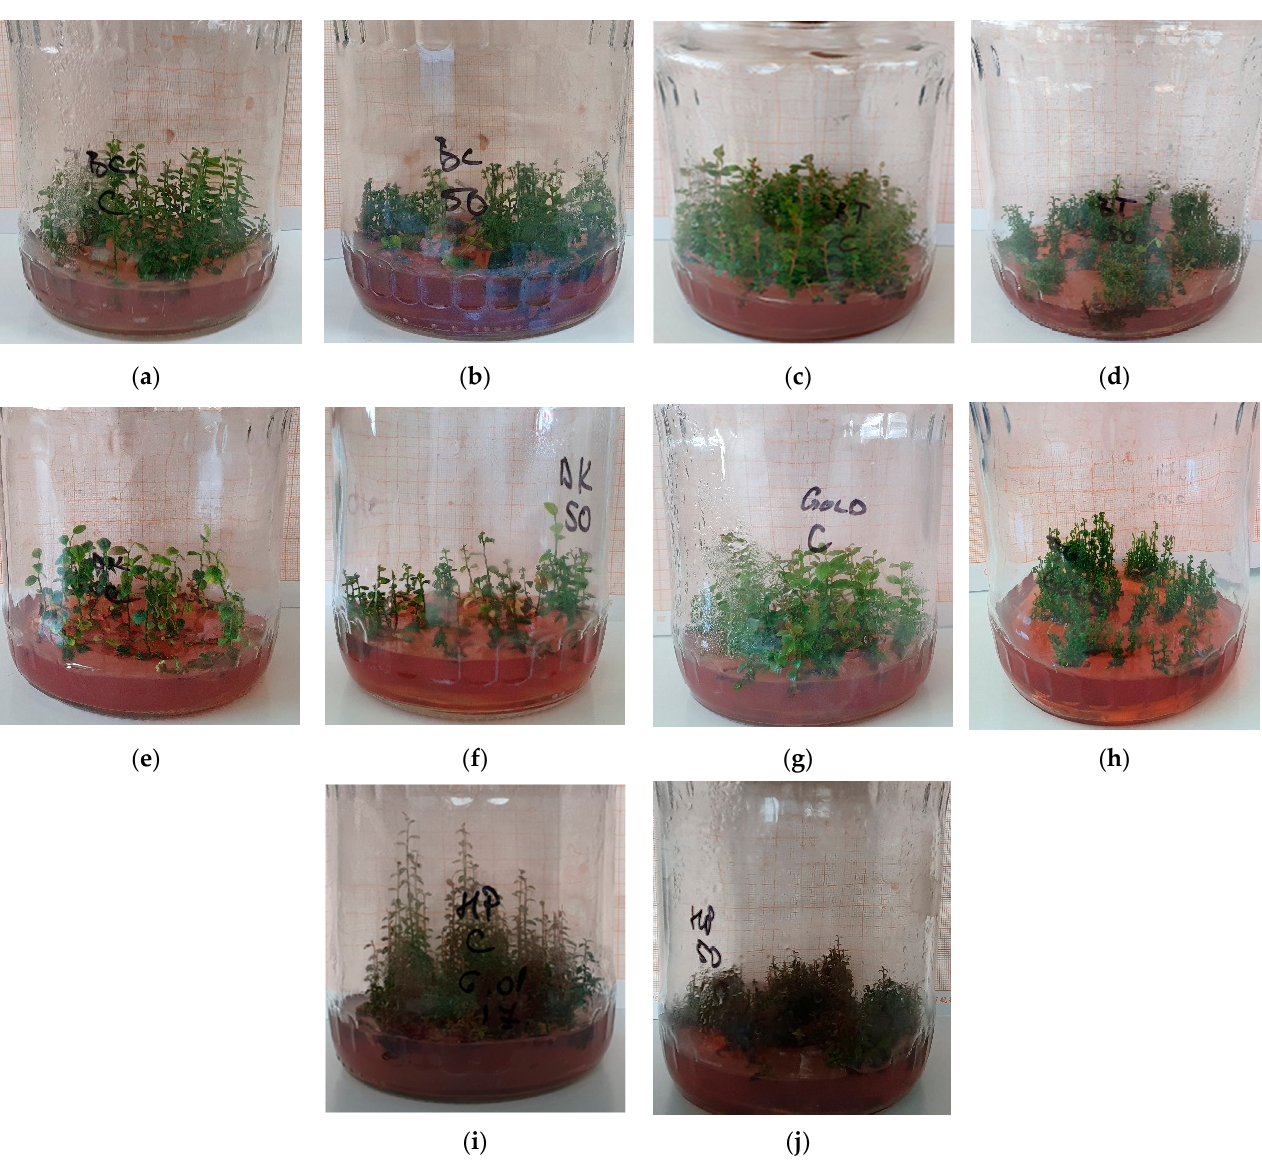
Figure 1. Effect of different concentration of polyethylene glycol (PEG-6000) on the growth and appearance of the in vitro culture of blueberry cultivars: ( a ) Bluecrop—WPM + 0 g/L PEG 6000; ( b ) Bluecrop—WPM + 50 g/L PEG 6000; ( c ) Brigitta Blue—WPM + 0 g/L PEG 6000; ( d ) Brigitta Blue— WPM + 50 g/L PEG 6000; ( e ) Duke—WPM + 0 g/L PEG 6000; (f) Duke—WPM + 50 g/L PEG 6000; ( g ) Goldtraube—WPM + 0 g/L PEG 6000; ( h ) Goldtraube—WPM + 50 g/L PEG 6000; ( i ) Hortblue Petite—WPM + 0 g/L PEG 6000; ( j ) Hortblue Petite—WPM + 50 g/L PEG 6000. Minishoots with length of 1.5–2 cm (16 inoculs/jar) of the five blueberry cultivars were used in this study, and polyethylene glycol (PEG 6000) was added to the medium [Woody Plant Medium (WPM) + 100 mg/L Sequestren 138 + 1 mg/L zeatin (Z) + 4 g/L Plant agar, pH = 5] at different concentrations (0 g/L, 10 g/L, 20 g/L, 30 g/L, 40 g/L, 50 g/L) to induce drought stress. Period of growth 12 weeks (22 ± 1 °C, 32.4 mmol·m − 2 ·s − 1 , 16-h photoperiod).